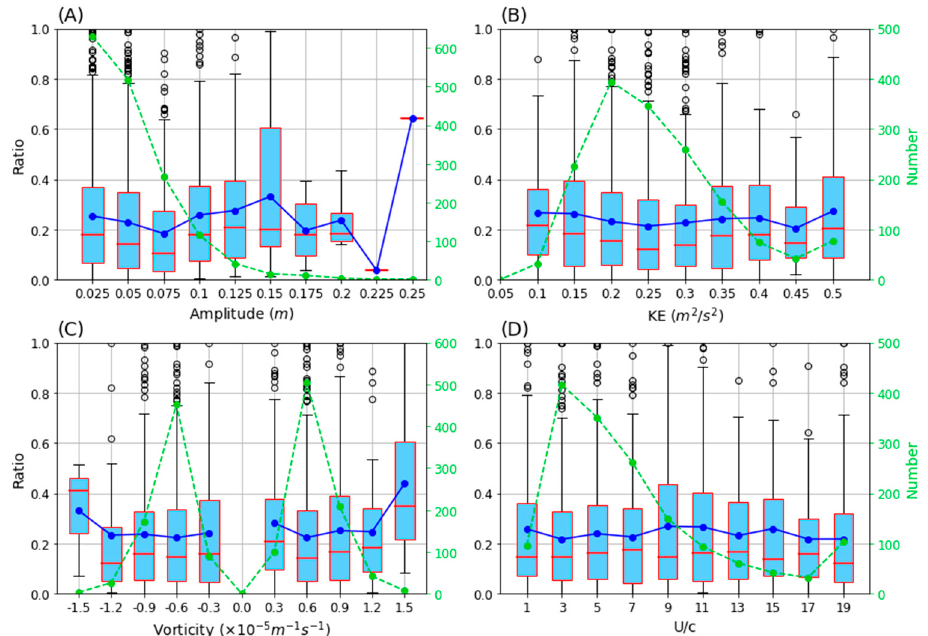
Figure 8. The percentage of particles remaining inside SSH eddies at the final time as functions of eddy ( A ) amplitude, ( B ) kinetic energy, ( C ) vorticity, and ( D ) U/c. Statistics of all eddies for different parameters are shown using a box-and-whisker plot. The red line indicates the median. The blue box covers the 25th to 75th percentiles of the distribution. The black whiskers indicate the 5th to 95th percentiles. The black circle symbols indicate the outliers beyond the 5th to 95th percentiles. The green dashed line indicates eddy numbers for different values of eddy parameters. The blue solid line represents the mean of each group.